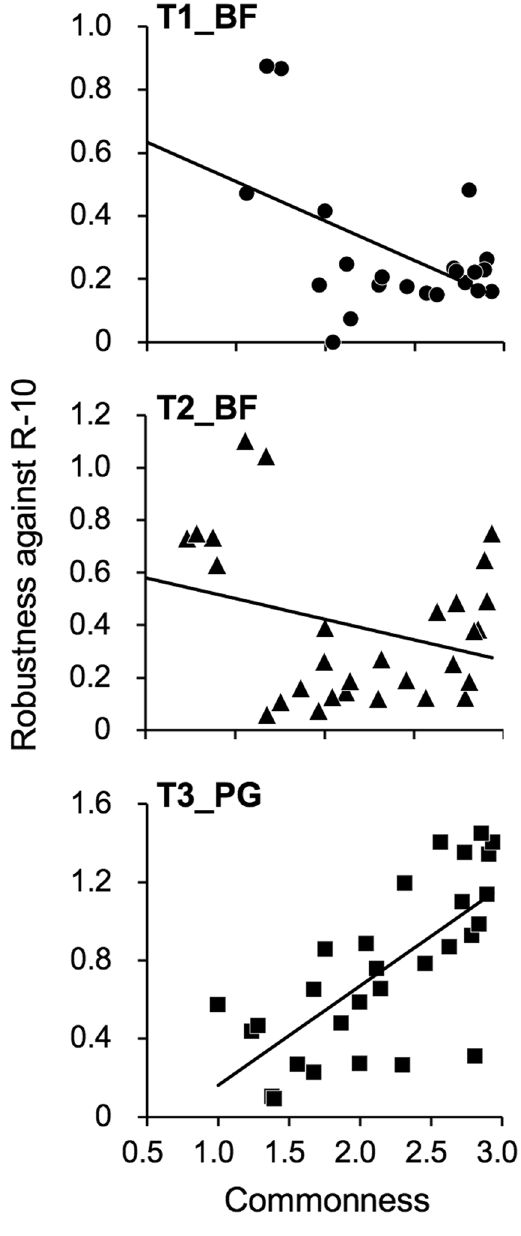
Figure 5. Correlation analysis between commonnesses and robustnesses of indigenous fungal OTUs in T1_BF (circles), T2_BF (triangles), and T3_PG (squares). Commonness that was referred to as niche breadth was calculated according to Pandit et al . 45 to evaluate their habitat specialization, and robustness against the inoculation of R-10 fungus was calculated as a ratio of the mean read abundance in the inoculated plots to that in the control plots. Pearson correlation coefficients ( R ) were − 0.50 ( p = 0.018), − 0.29 ( p = 0.12), and 0.72 ( p < 0.001) in T1_BF, T2_BF, and T3_PG,